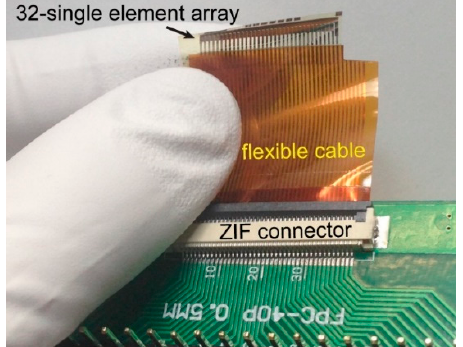
Figure 3. 1-D array of 32 single element PZT thin-film transducers on a 5 µm polyimide layer. A flexible cable connects the transducer elements to a printed circuit board. Anisotropic conductive film (ACF) bonding was used to join the cable and the flexible sample while the cable was inserted to a zero insertion force (ZIF)